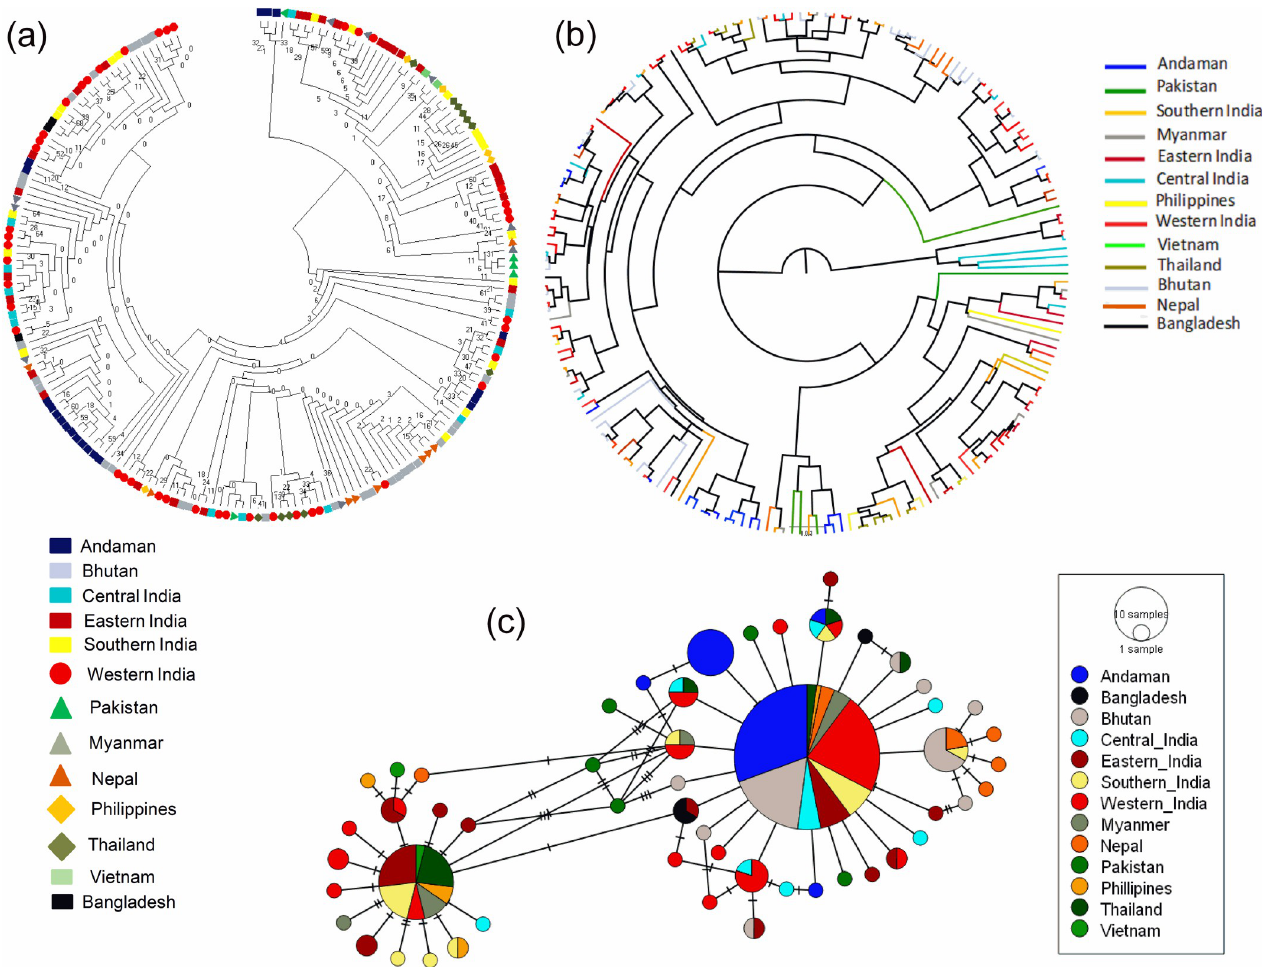
Fig 6. Haplogroup I2 and its relationship with I2 haplogroup cattle of Island Southeast Asian countries and Indian subcontinent. (a) Neighbor Joining (NJ) phylogenetic tree, (b) Bayesian phylogenetic tree, (c) A haplotype network map of the haplotypes.